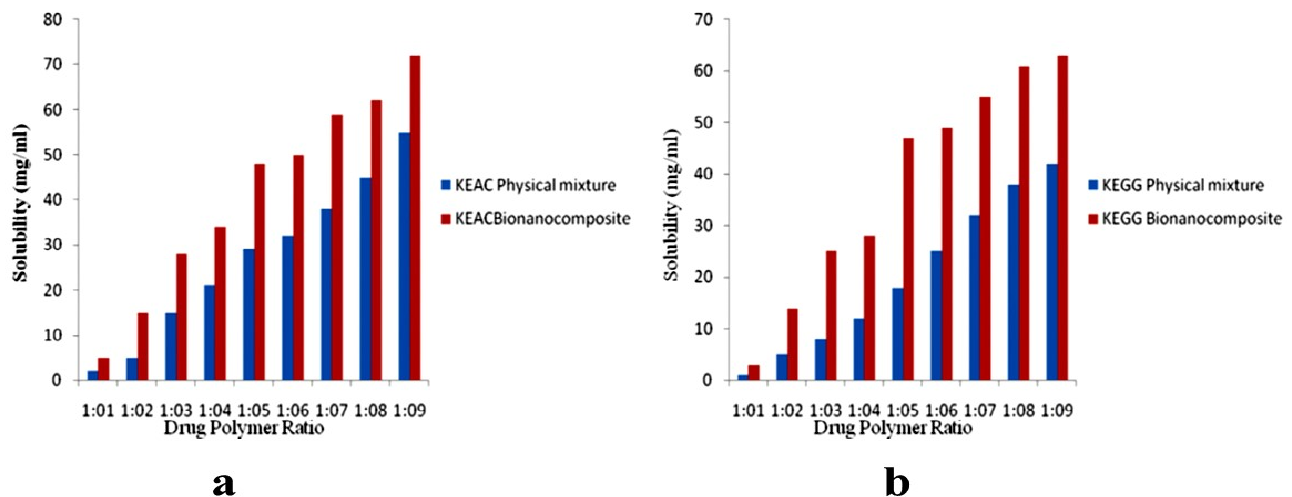
Figure 31. ( a ) Comparison of the solubility between the physical KEAC combination and KENC. ( b ) Correlations of solubility in KEGG physical blend and KEGG bio-nanocomposite. The information is the average ± SD, n = 3. The results are expressed in terms of the solubility percentage of virgin ketoprofen, where: KE–ketoprofen, AC–acacia, GG–ghatti gum, SD–standard deviation. Reproduced with permission from [335].